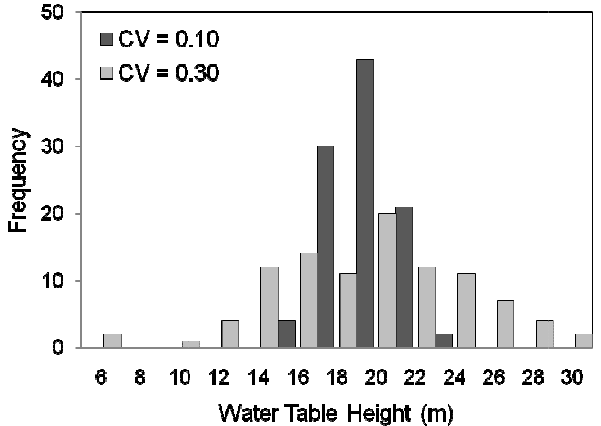
Fig. 10. Spatial distribution of the mean of the updated Y K en- value of 18.5 m semble using Y Q data from four gaging stations along the stream channel sampled four times during the 365-day period, with the CV of observation data set to 0.0. Compare to the true state shown in Fig.